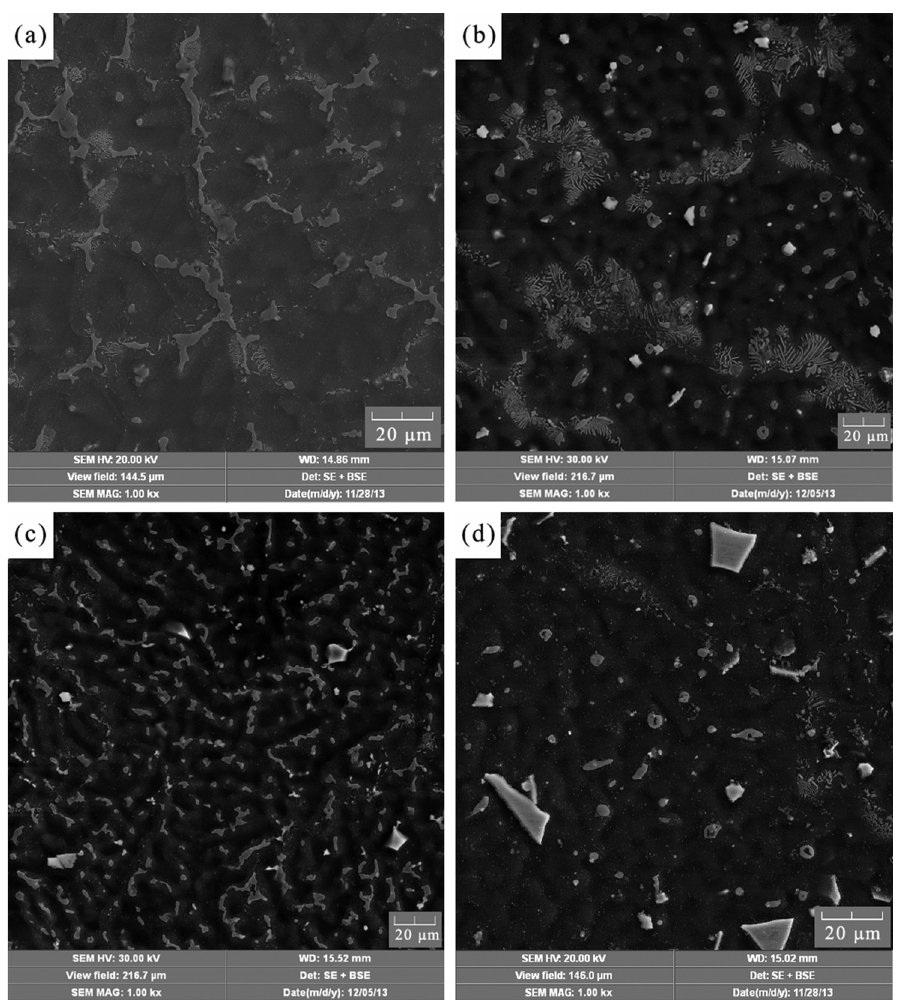
Figure 3: SEM images of the as-cast AZ80 – 2Sn alloys with different Y additions: (a) alloy 1; (b) alloy 2; (c) alloy 3; (d) alloy